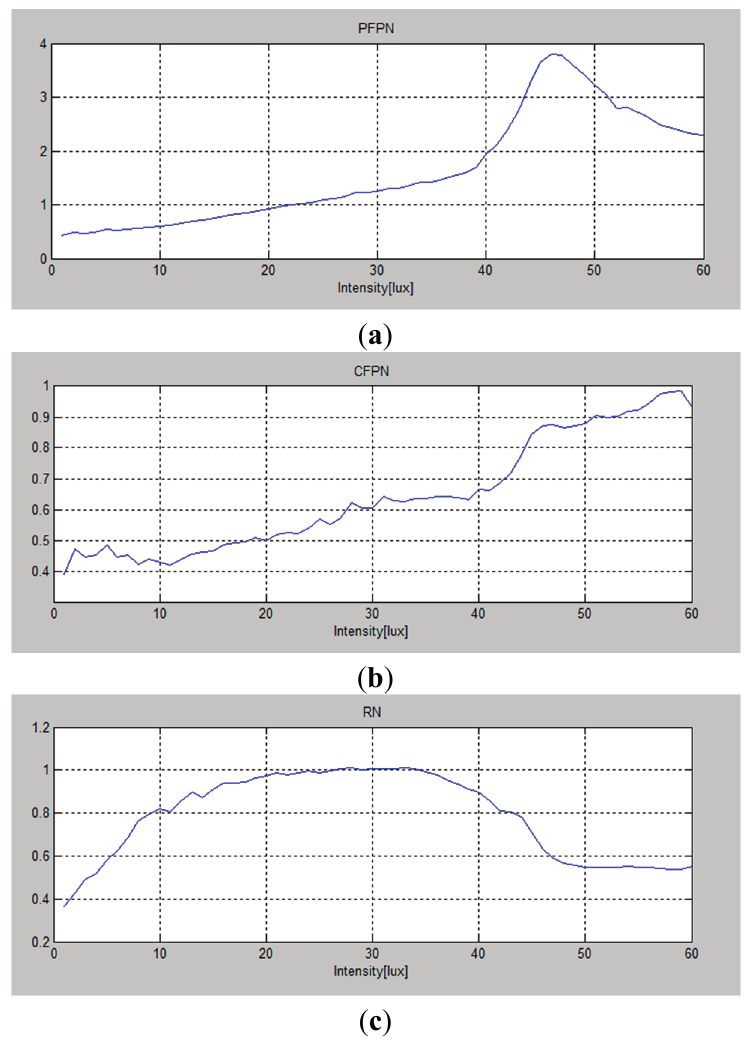
Figure 13. Measured data dependent on the variation of light intensity: ( a ) pixel fixed pattern noise (PFPN); ( b ) column fixed pattern noise (CFPN); ( c ) random noise